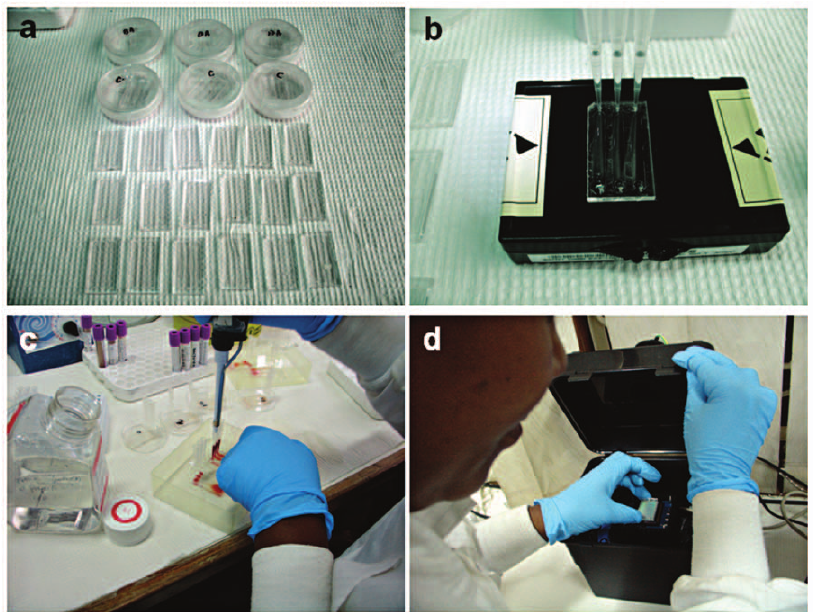
Figure 2. Overview of Microfluidic CD4 counting chip preparation, blood injection, and lensless imaging procedures by minimally trained personnel at MUHAS. ( a ) Unpacking of the microfluidic chips, ( b ) antibody injection, ( c ) one step blood injection, ( d ) microfluidic CD4 count chip imaging using a point-of-care portable, battery operated lensless CCD based imaging platform.